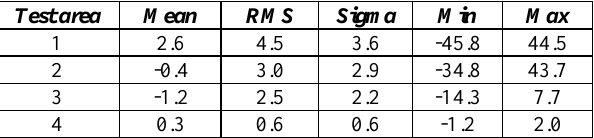
Table 3. Statistics of height differences between generated